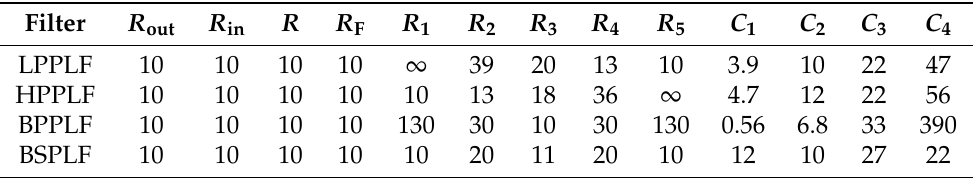
Table 5. Values of the passive components for the realization of the proposed PLFs ( α = 0.5 ) (Note: All resistances are in k Ω , and all capacitances are in nF).